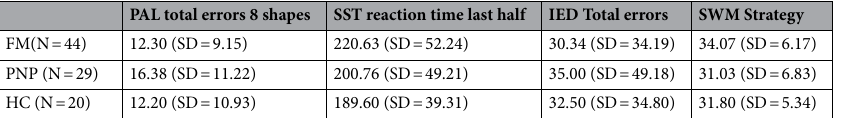
Table 1. Four theoretically selected outcomes from the CANTAB test battery were used as executive functioning tests in patients with confirmed fibromyalgia (FM) or peripheral neuropathic pain (PNP) or healthy volunteers (HC). The test results are presented as mean and standard deviation